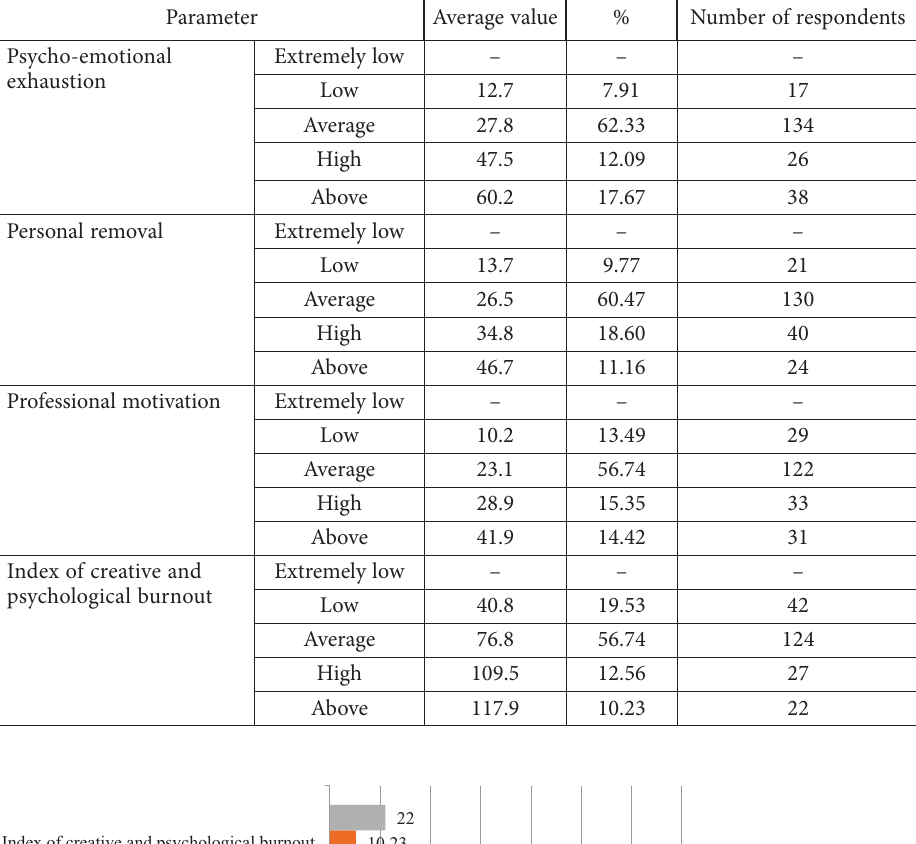
Table 3. Parameters of creative and mental burnout according to the second method (source: created by authors)